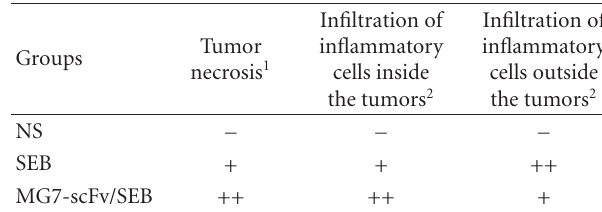
Table 1: The infiltration of inflammatory cell and necrosis of tumor nodule in gastric-cancer-bearing rats after combined therapy with MG7-scFv/SEB, SEB, or